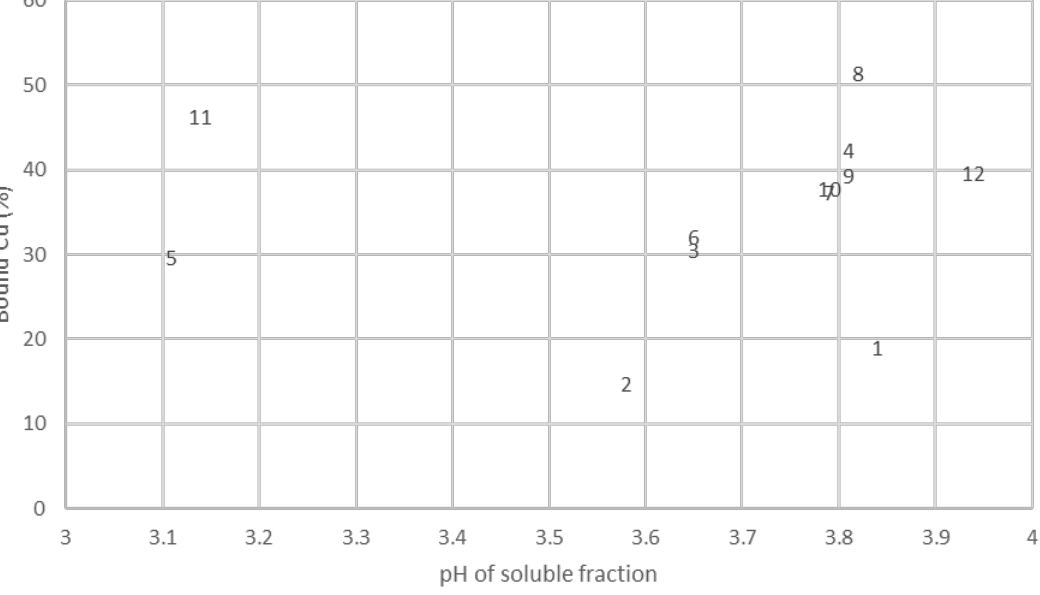
Figure 4. ISE titrations ( n = 3) of bound Cu in proteinates containing 10% ( w/w ) Cu. 1 – 12 refer to the individual hydroly- sates outlined in Table 1.